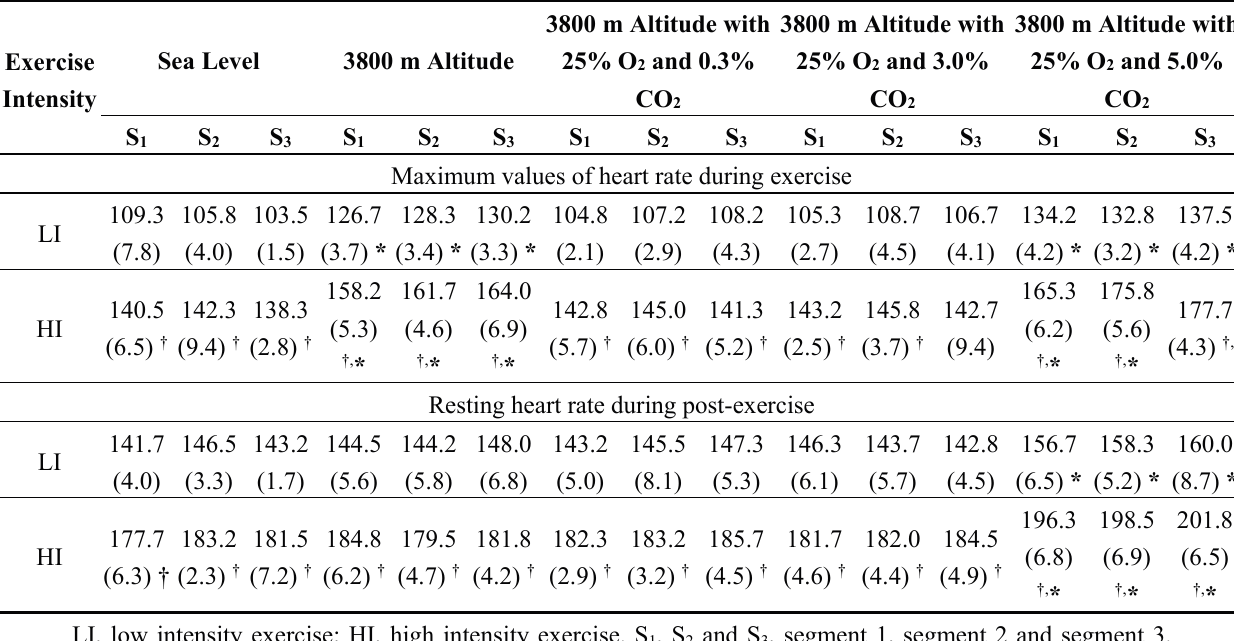
Table 3. Heart rate (Mean (SD), bpm) in exercise test.